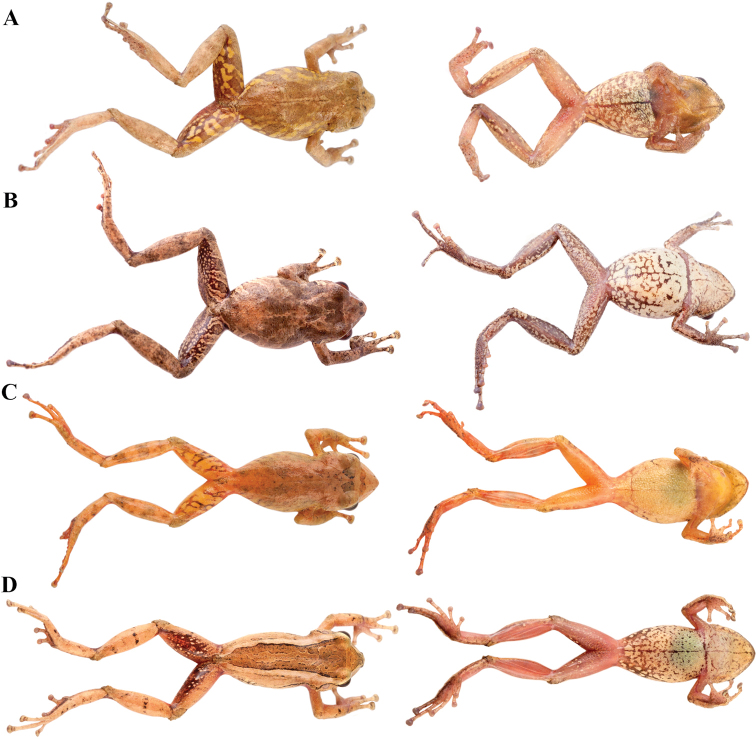
Color variation in live individuals of Pristimantis
jimenezi sp. nov. AQCAZ 45170 (holotype, male, SVL 24.1 mm) BQCAZ 45179 (female, SVL 32.2 mm) CQCAZ 46977 (male, SVL 26.8 mm) DQCAZ 46978 (female, SVL 34.8 mm). Dorsal view on the left, ventral view on the right.